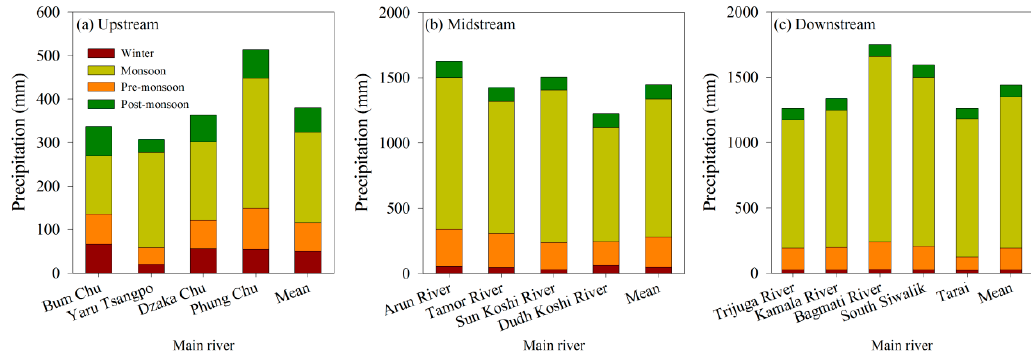
Figure 7. Precipitation from different rivers in Koshi River Basin (KRB).